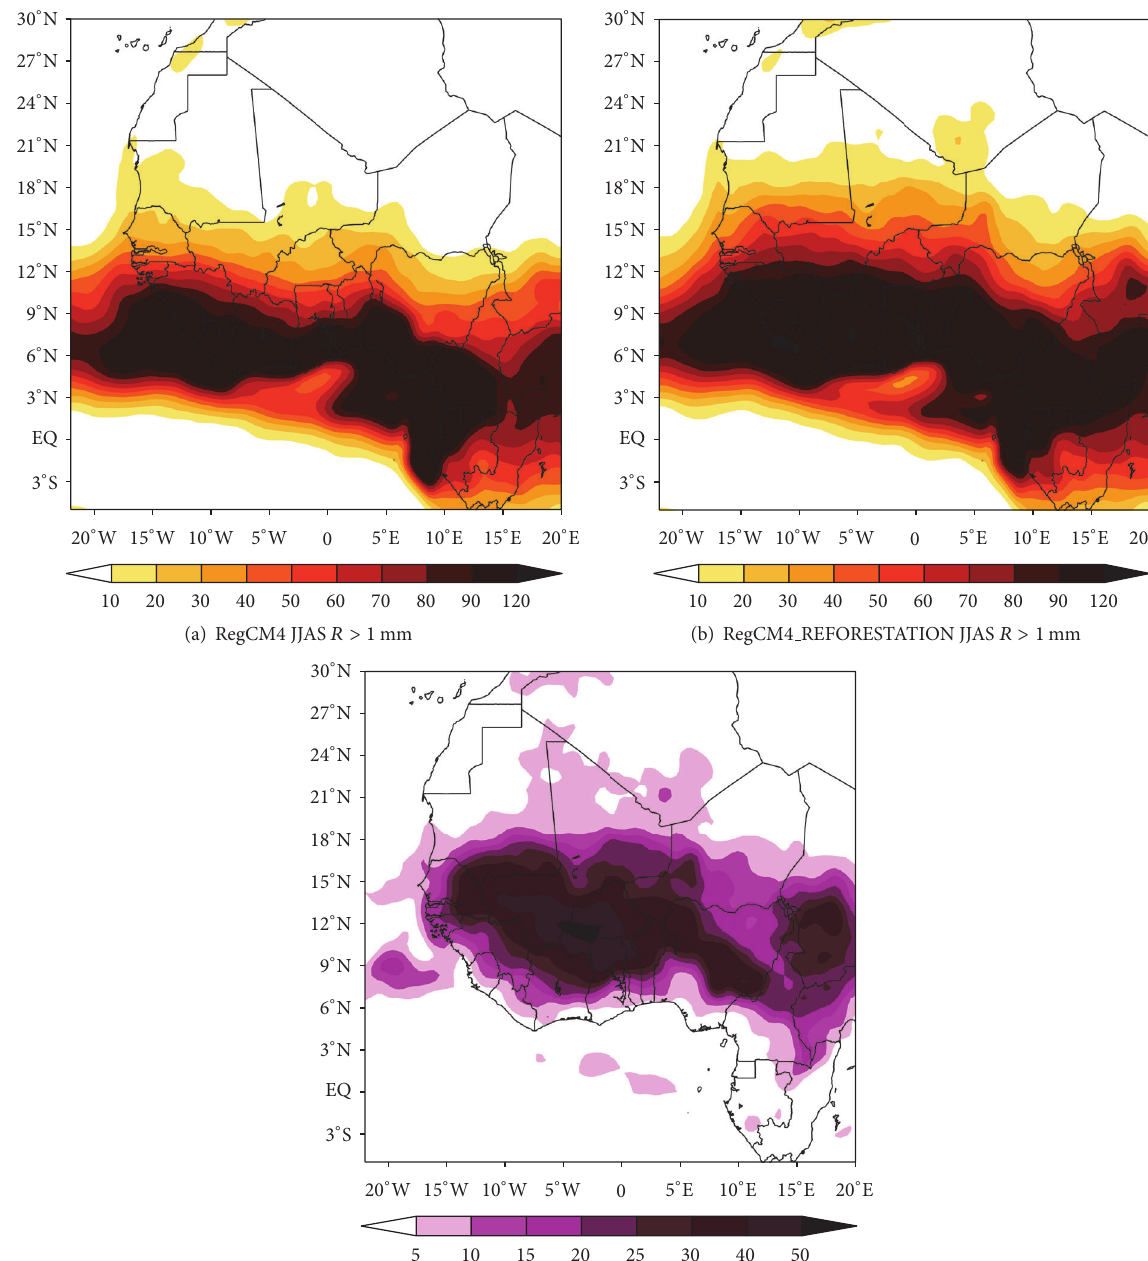
Figure 8: Number of rainy days (daily cumulative precipitation greater than 1mm) during the summer period (JJAS) averaged from 2003 to 2009 for both runs and their